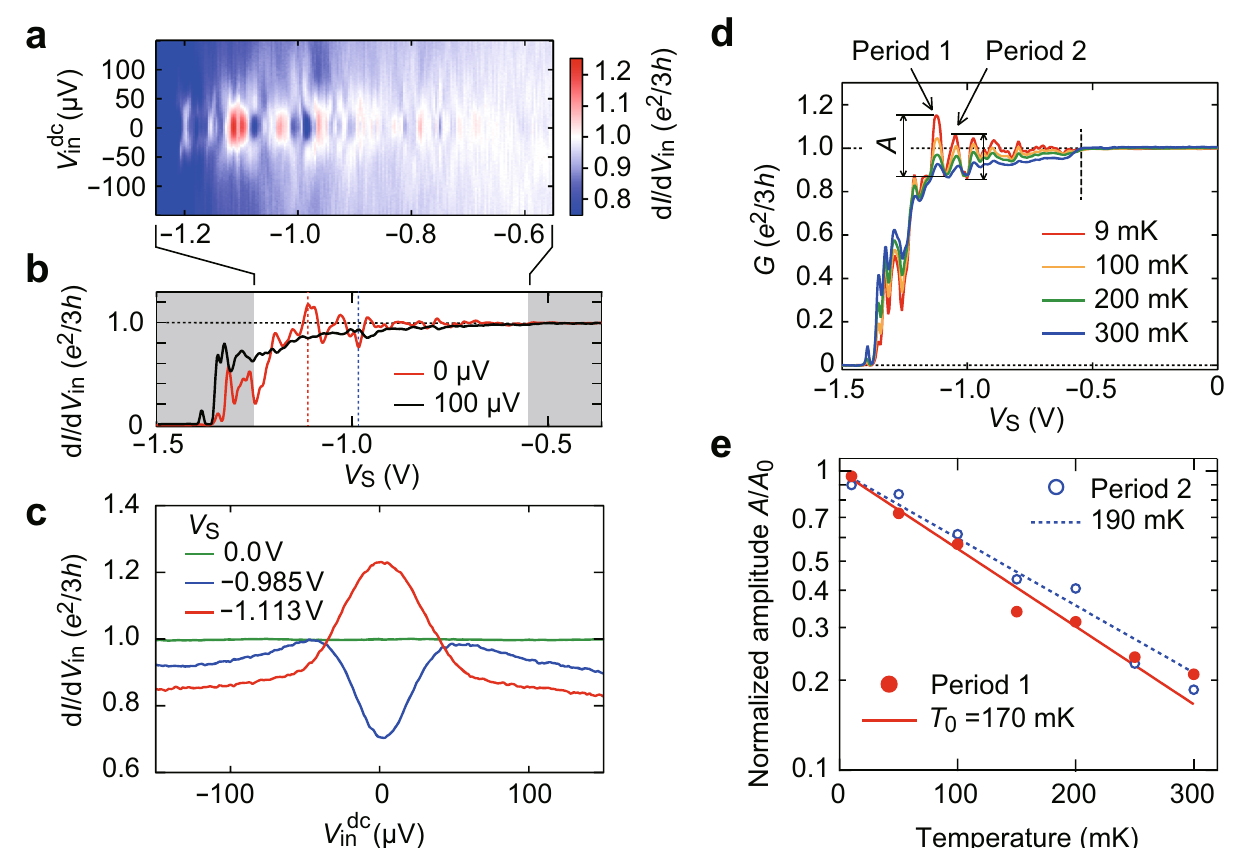
Fig. 3 Source – drain – voltage and temperature dependence of conductance oscillations. a Colour plot of d I /d V in as a function of V S and V in dc , indicating oscillations with d I /d V in > e 2 /3 h at | V in | < 40 μ V. b Comparison of d I /d V in vs. V S traces at zero and fi nite bias, indicating that the feature d I /d V in > e 2 /3 h is absent at V in dc = 100 µ V. c V in dc dependence of d I /d V in at several V S . Zero-bias conductance enhancement (suppression) is observed at V S = − 1.113 V ( − 0.985 V), whereas no feature is seen without forming a narrow junction ( V S = 0 V). d G vs. V S traces measured at several temperatures. The amplitudes A of the oscillations in periods 1 and 2 are estimated as the peak-to-valley values. e Temperature dependence of A / A 0 for periods 1 and 2. The curves of the form exp( − T / T 0 ) well fi t the data using similar characteristic temperatures ( T 0 = 170 and 190